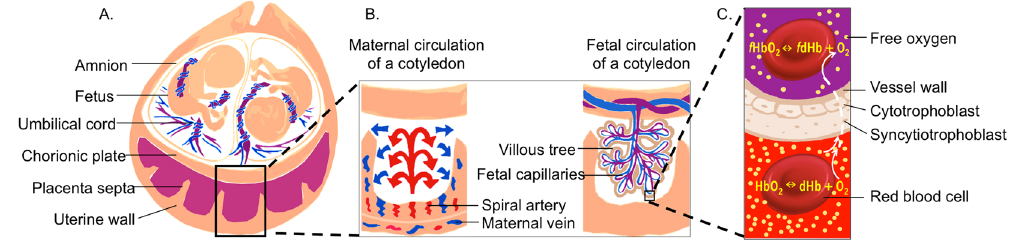
Figure 1. Schematic diagrams depicting ( A ) the main components of a monochorionic diamniotic twin gestation. The magnified views in ( B ) represent the maternal placental circulation (left) and the fetal placental circulation (right) with an inset cartoon ( C ) representing oxygen transport from mother to the fetuses. Oxygen exchange between maternal hemoglobin and fetal hemoglobin by free diffusion across the interhemal membrane, and is modulated by the oxygen gradient, membrane permeability, and blood flow in both